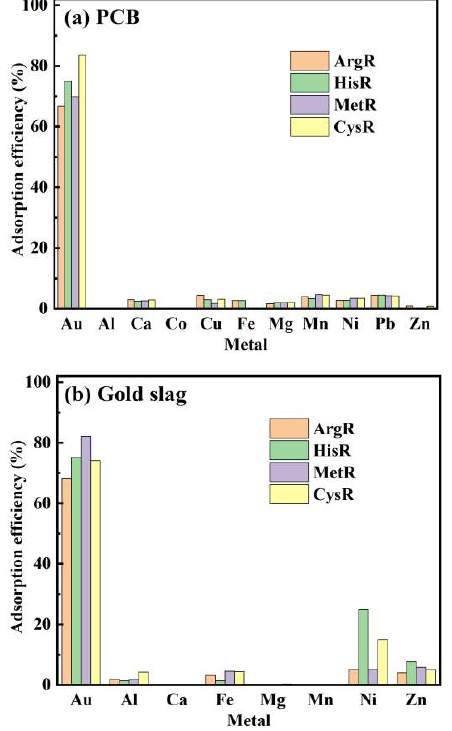
Figure 9. The adsorption efficiency of amino acid resins for different metals.